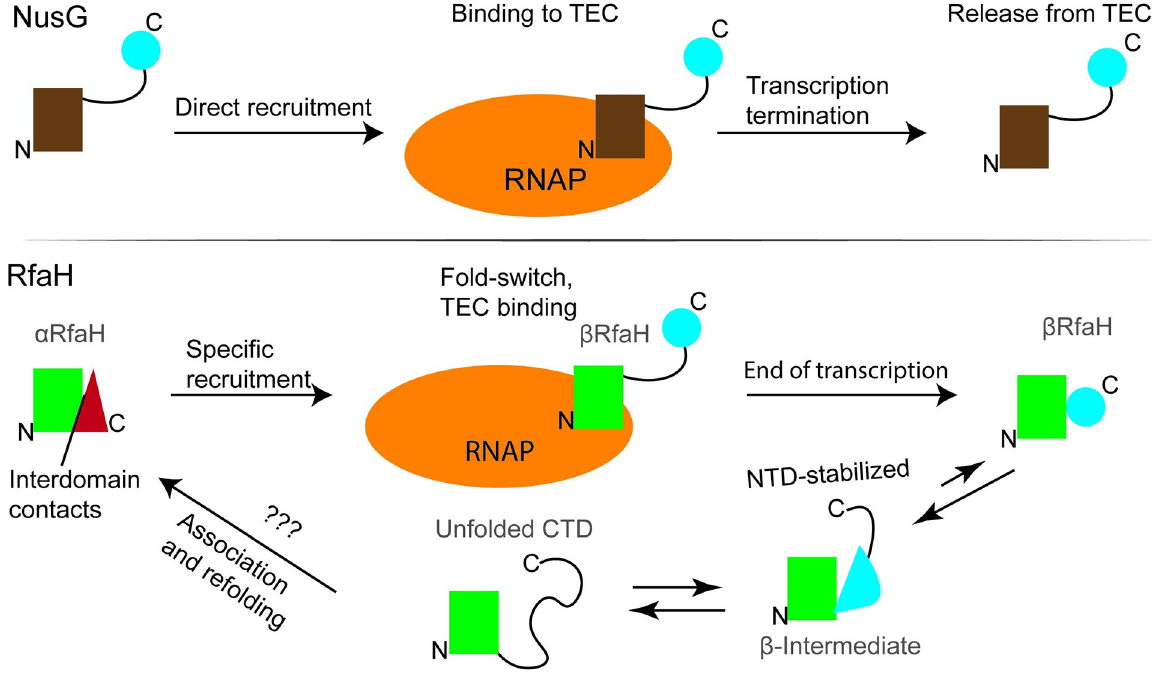
Fig 1. Schematic representation of the folding states of NusG (top) and RfaH (bottom) upon binding to and release from the transcription elongation complex (TEC). For RfaH a fold-switch is involved in this process, in which the steps after release from the TEC corresponding to partial unfolding into a β -intermediate and transiting the unfolding state before refolding into the autoinhibited state are based on the results presented in this article.